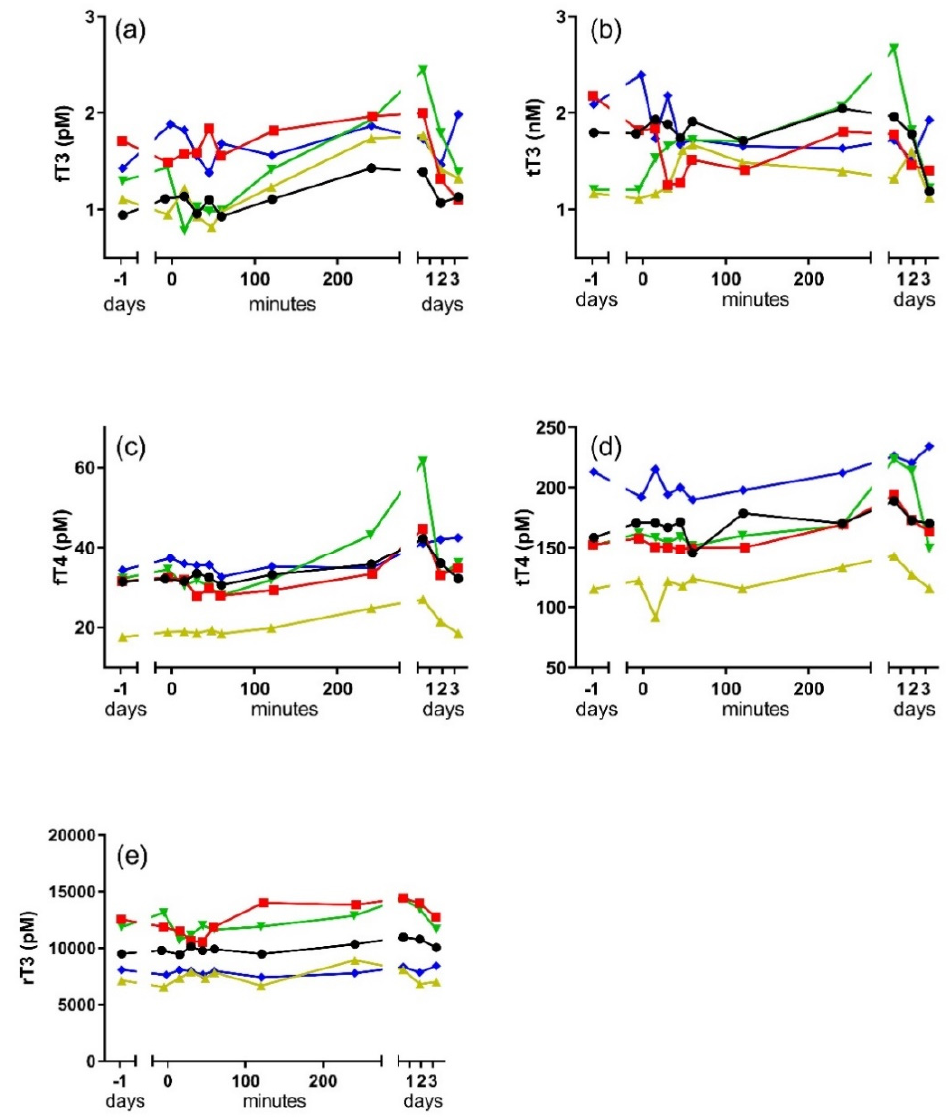
Figure 1. Change in bottlenose dolphin thyroid hormones in response to an intramuscular TSH injection. Values along the x-axes are sample times relative to the time of the TSH injection (time = 0). ( a ) fT3, ( b ) tT3, ( c ) fT4, ( d ) tT4, ( e ) rT3.